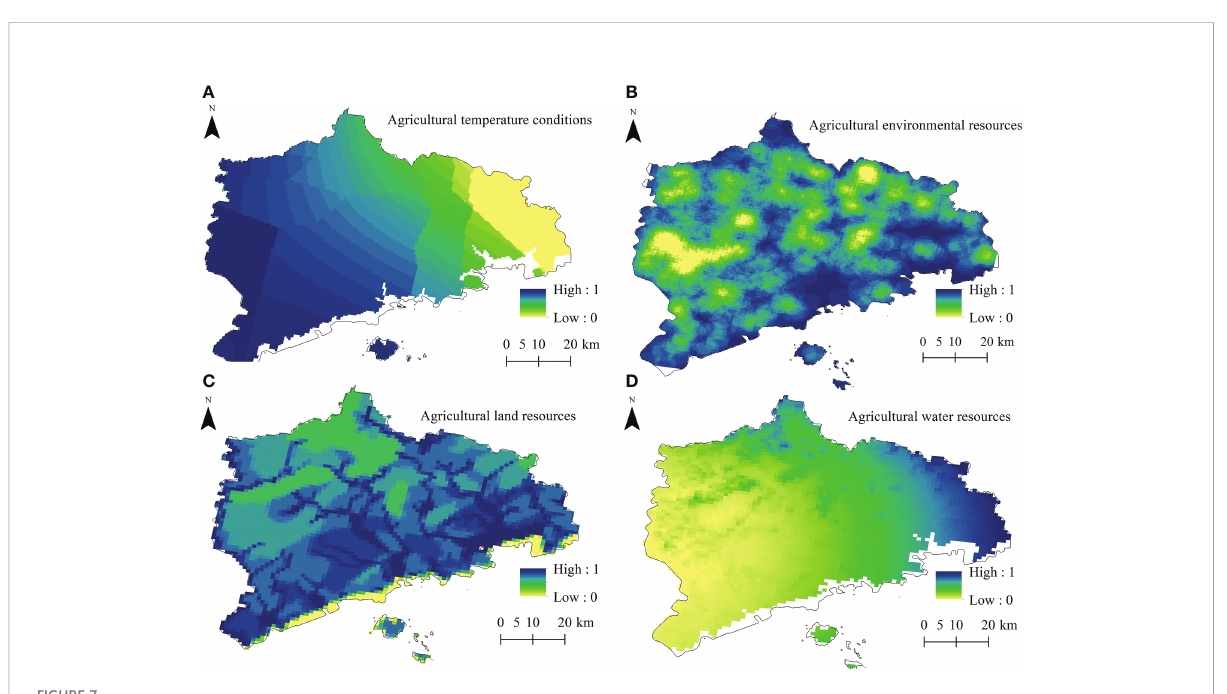
FIGURE 7 Factors for evaluating the suitability of agricultural production.